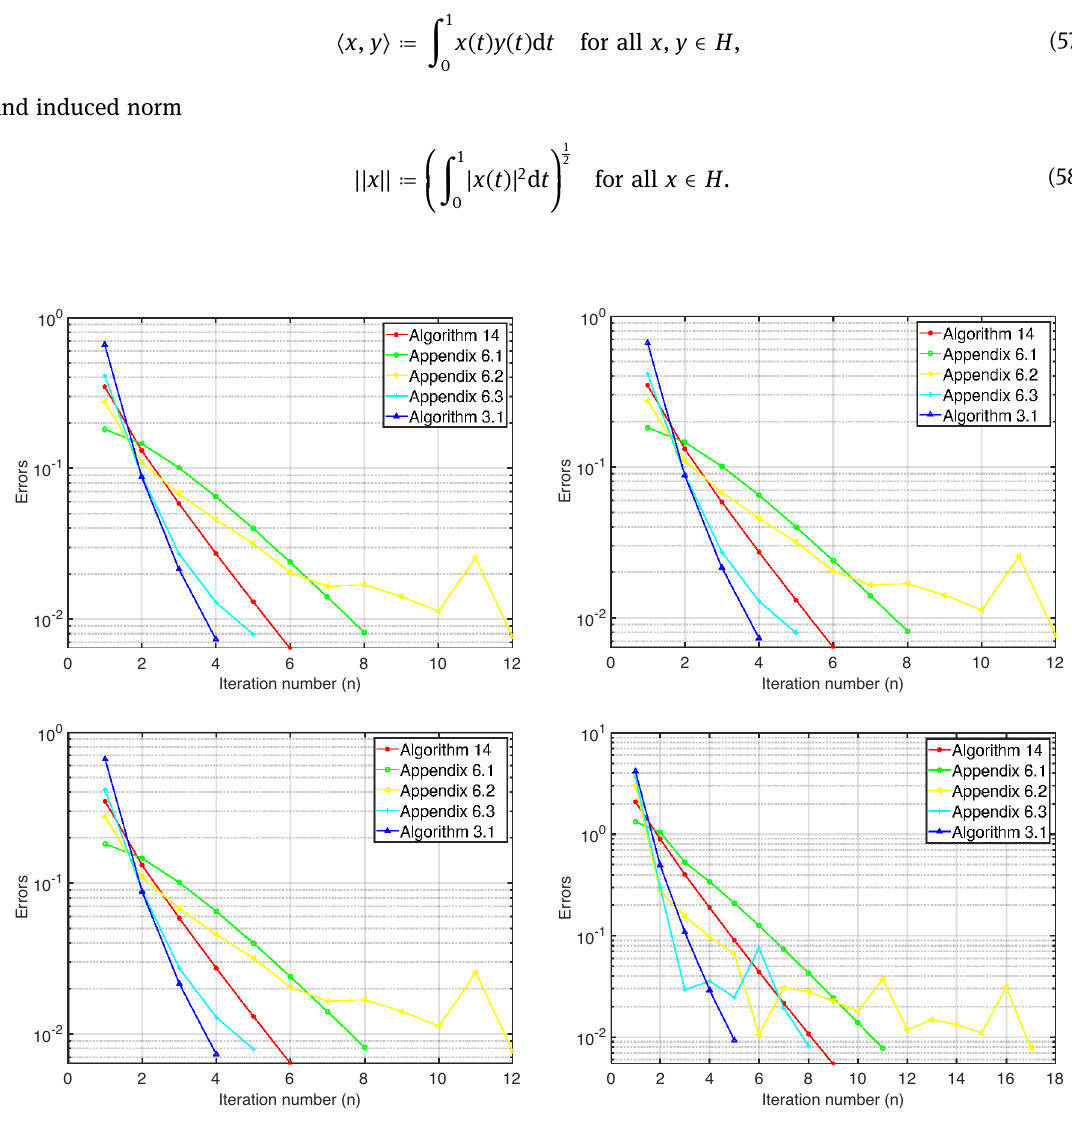
Figure 2: Top left: Case I; top right: Case II; bottom left: Case III; bottom right: Case